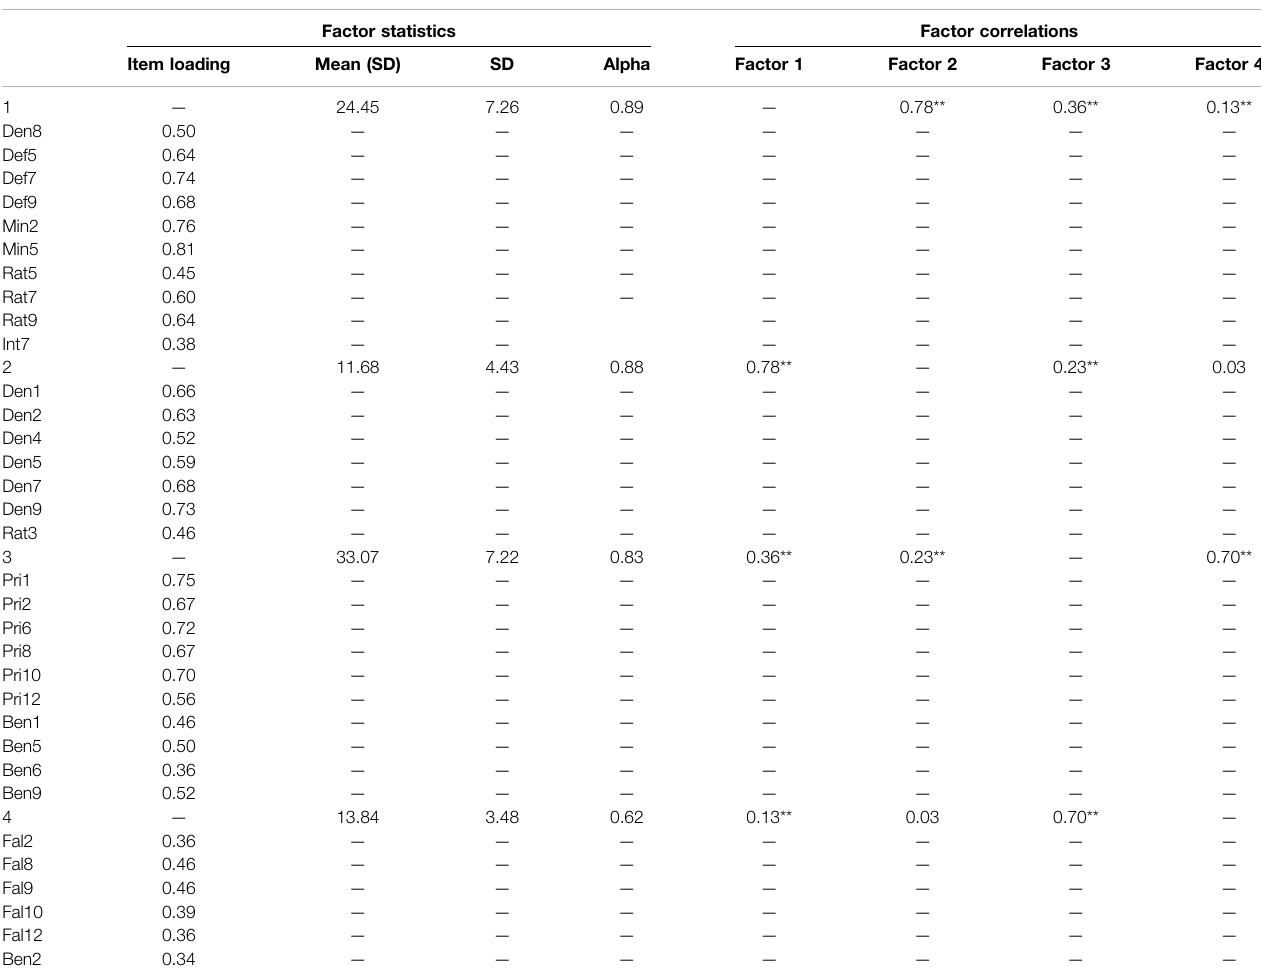
TABLE 2 | Factors, items, and factor loadings for EFA